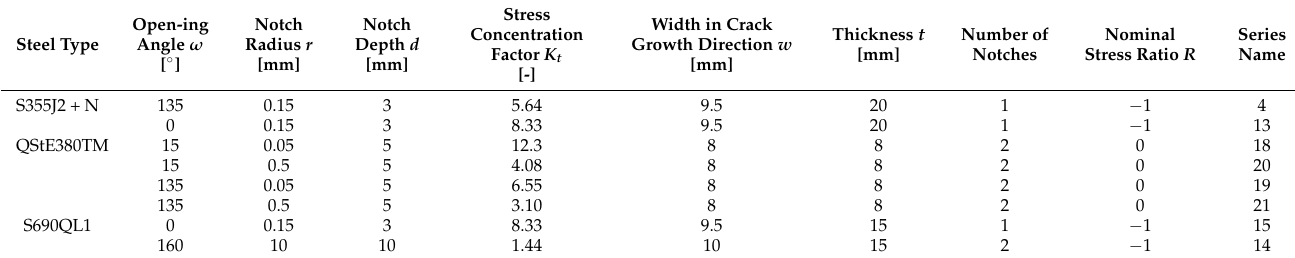
Table 2. Overview of base material-type